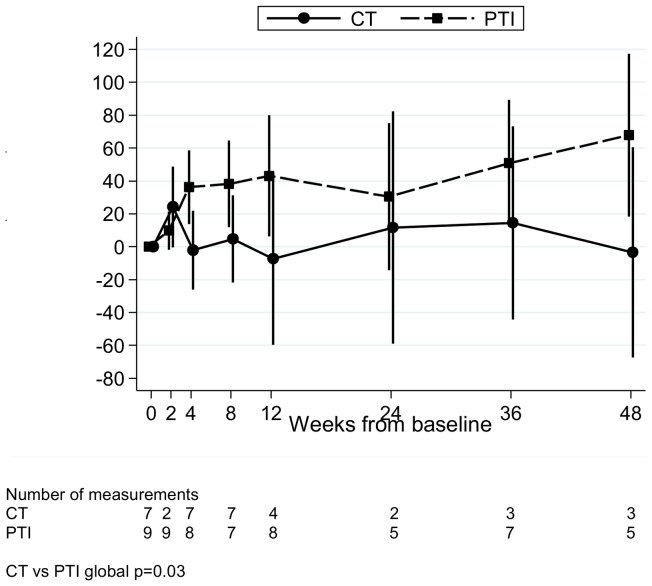
Relative change in HIV DNA copies/106 PBMC from baseline.Relative change in HIV DNA copies/106 PBMC from baseline for children in the substudy. CT = continuous ART (antiretroviral therapy), PTI = planned treatment interruption (off ART), PBMC = peripheral blood mononuclear cells.